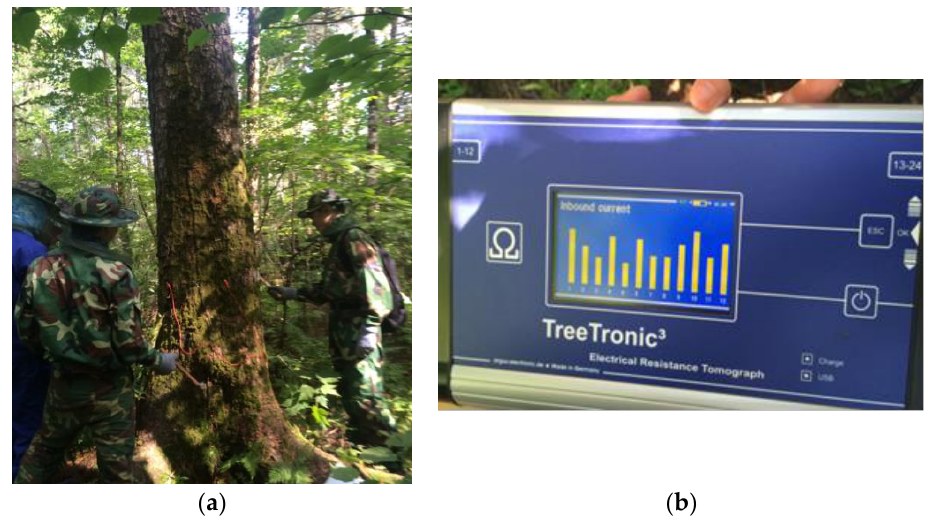
Figure 1. The field test of electric resistance tomography. ( a ) Arranging the electrode; ( b ) Current histogram displayed on the